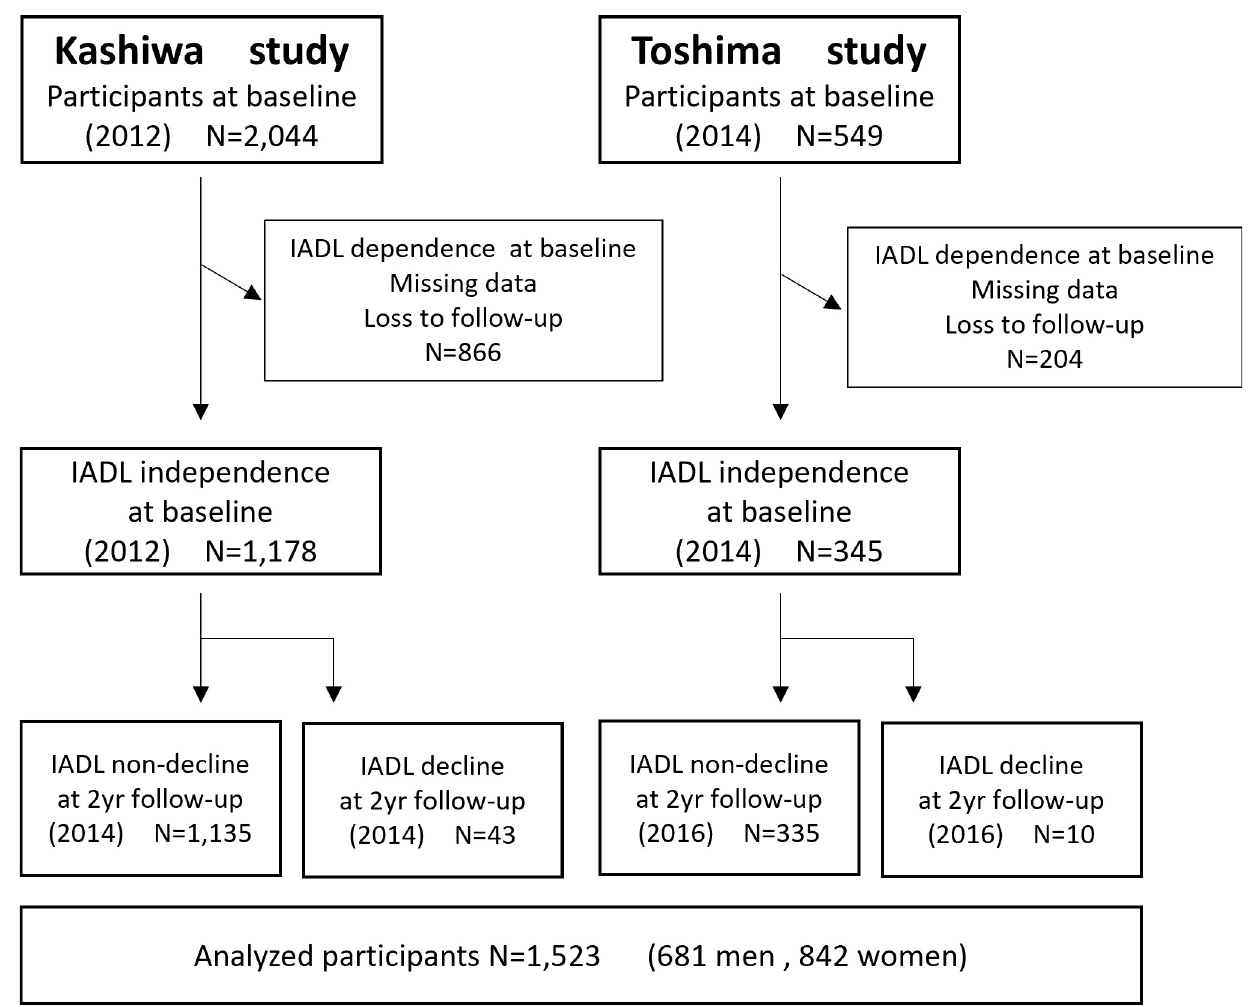
Fig 1. Flow diagram of participants analyzed in this study.